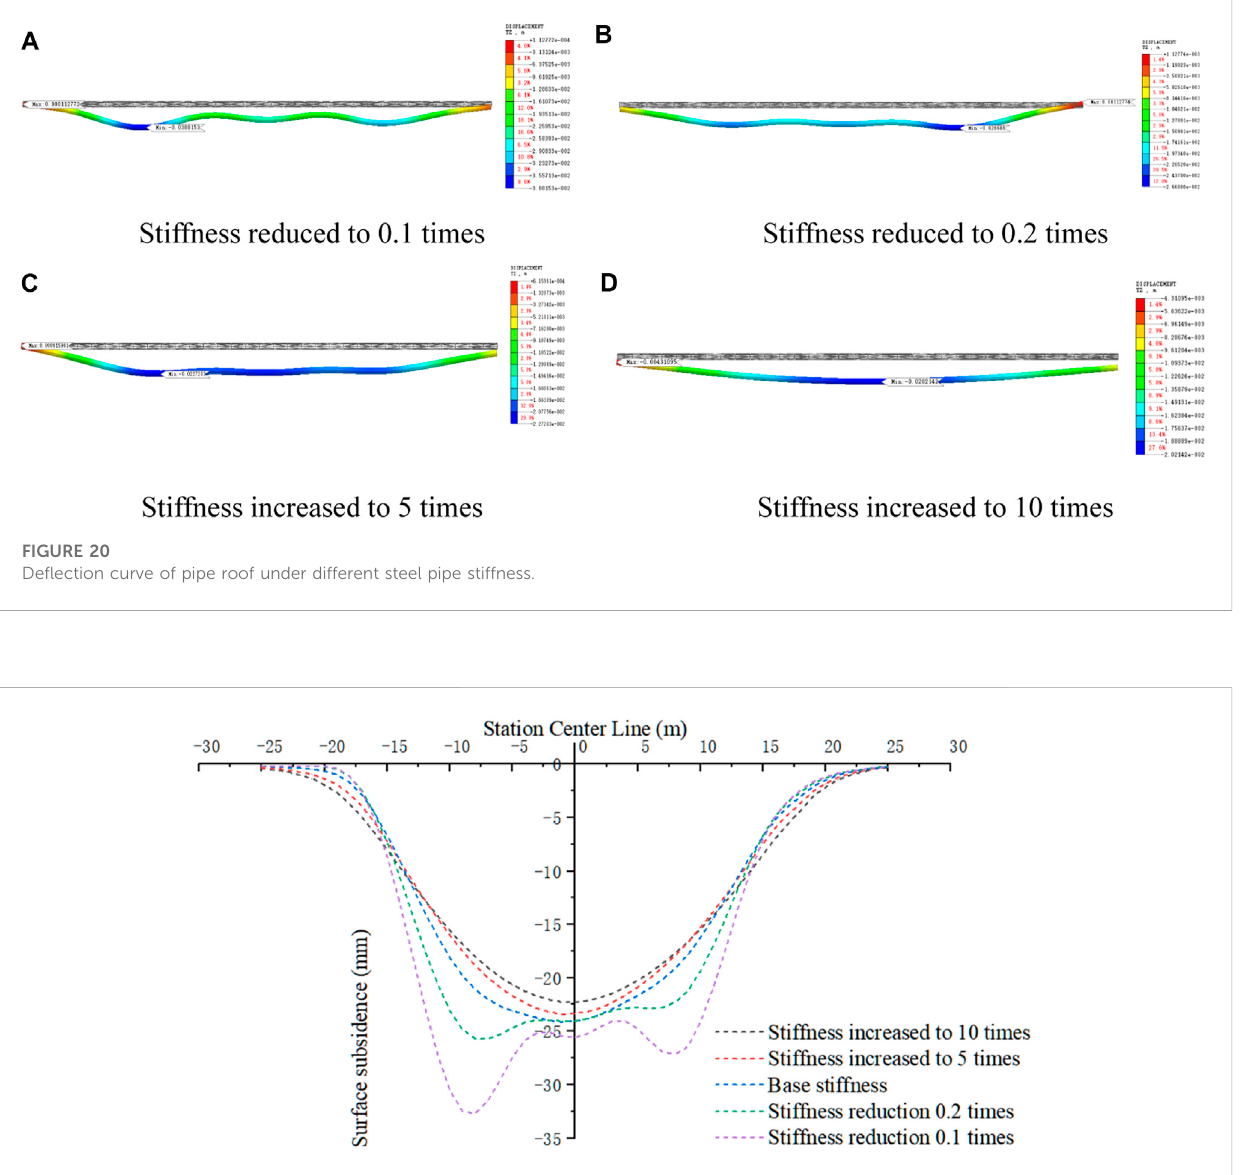
FIGURE 21 Curve of ground settlement under different steel pipe